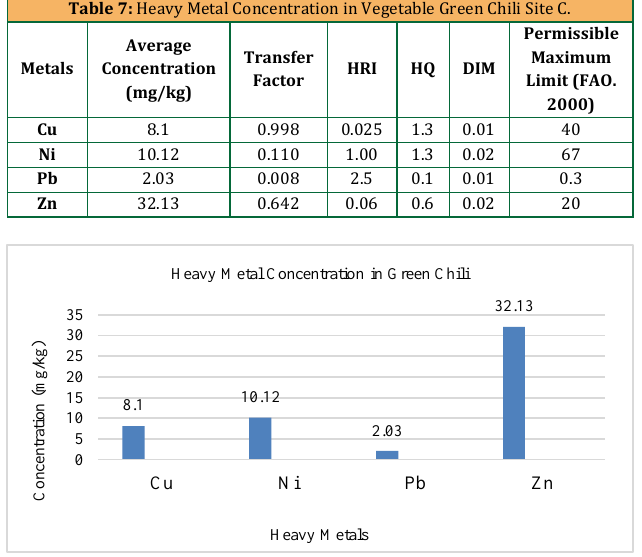
Figure 4: Average concentration in green chili Site C